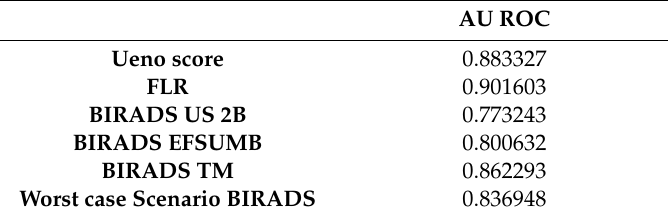
Table 8. Area under the Receiver Operating Characteristic (ROC) curve for each diagnostic